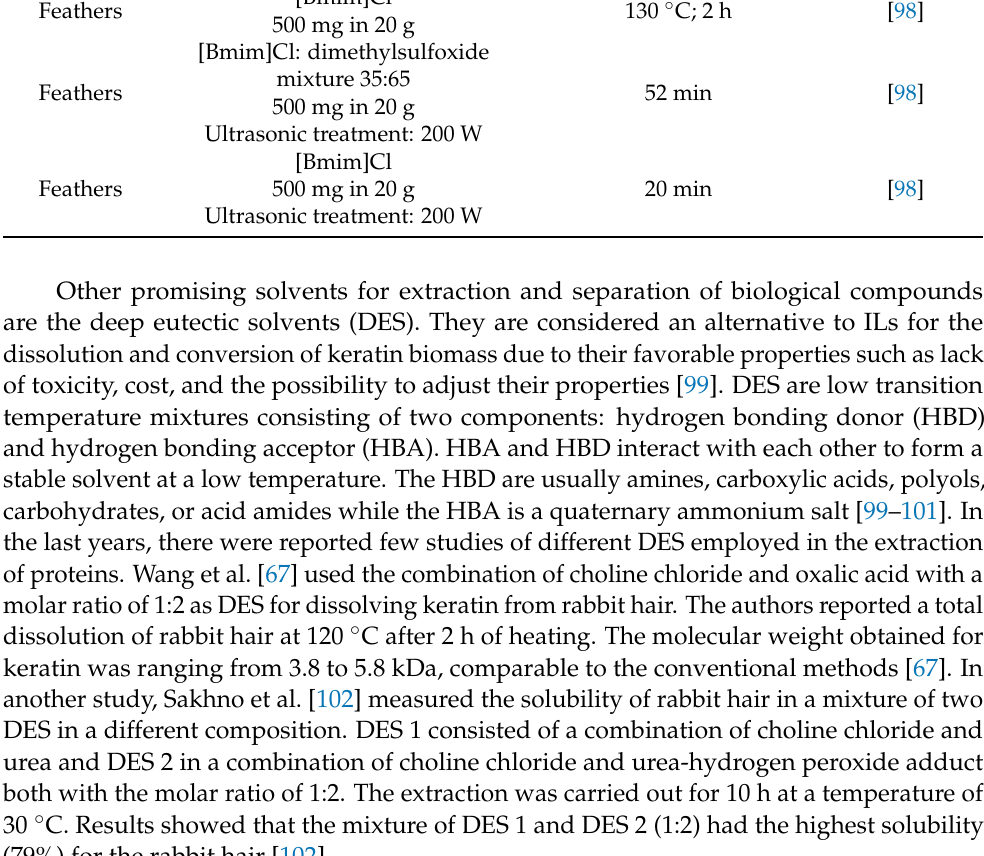
Table 6. Ionic liquids and processing parameters used for the keratin extraction. Processing Parameters Keratin Source Extracting Solution